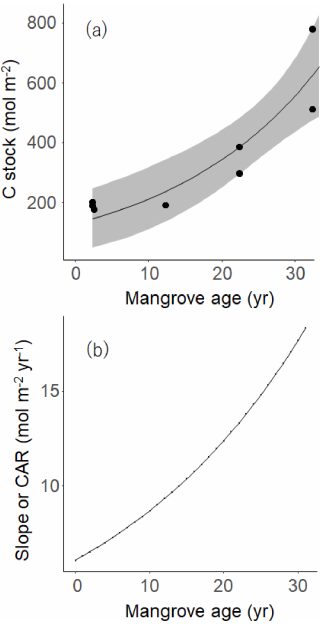
Figure 7. (a) The relationship between mangrove age ( Age ) and car- bon stock, where the curve was drawn based on an exponential func- tion model in Eq. (2): OC = 171 . 07exp ( 0 . 03558 · Age ) and R 2 = 0 . 9873. The gray band means 95% confidence interval. (b) The relationship between mangrove age and carbon accumulation rate (CAR) on the basis of the exponential model (see Eq.